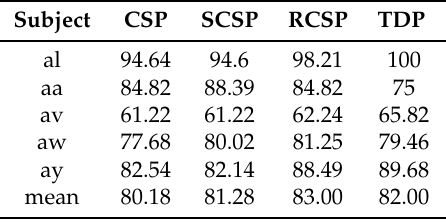
Table 2. Classification accuracy of the CSP variations and TDP algorithm for 18 channels ( K = 18) BCI Competition III Dataset IVa.